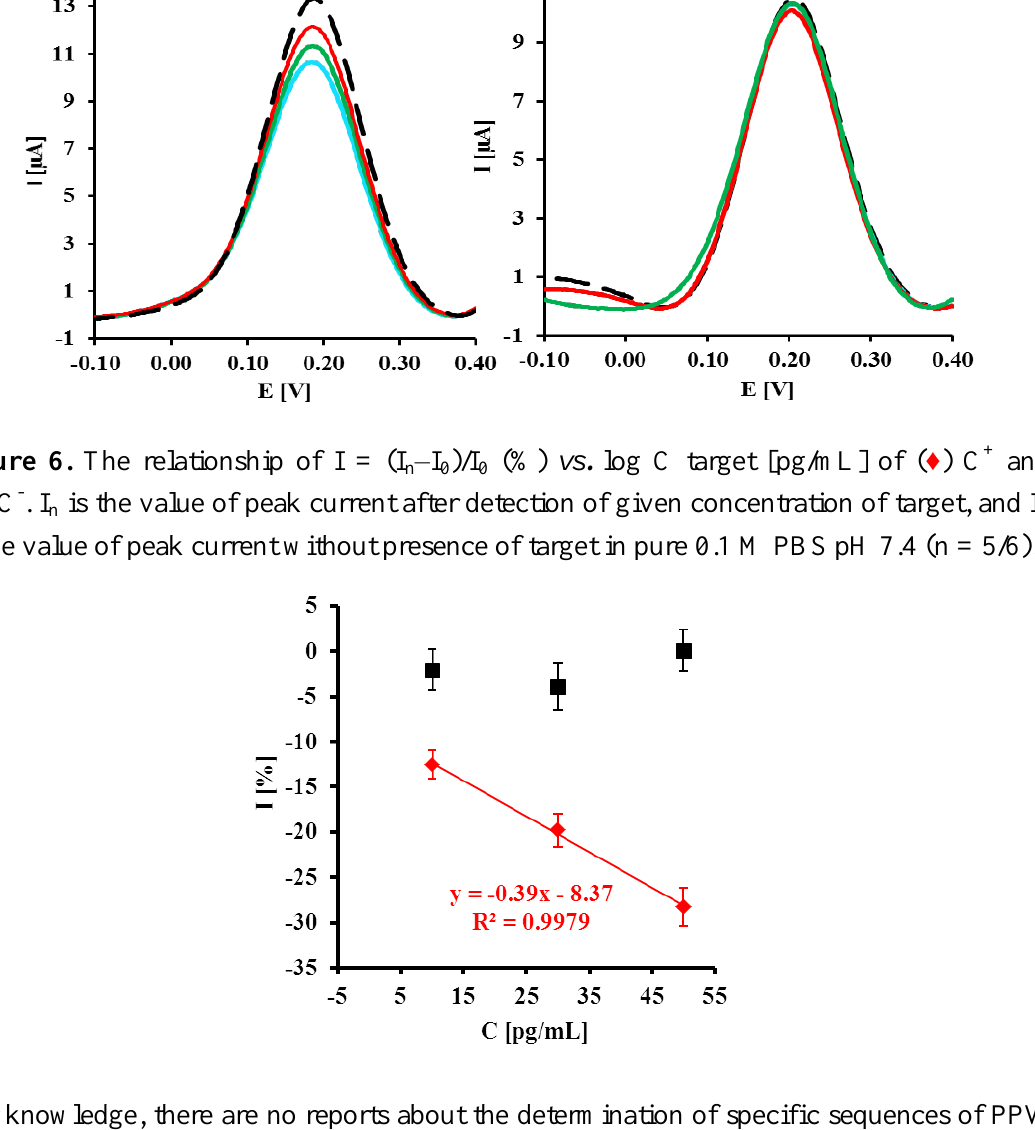
Figure 5. Typical OSWV curves obtained for electrodes modified with GCE-CO-NH-ssDNA-EA upon hybridization with DNA samples from plant extracts. Dashed curve—before hybridization and the following curves upon hybridization with target ( A ) C + PPV and ( B ) C − PPV at the concentrations: 10, 30 and 50 pg/mL. Solution composition: 1 mM [Fe(CN) ] 3−/4− in 0.1 M PBS (pH = 7.4). The measurement conditions: 6 three electrode configurations: GCE-CO-NH-ssDNA modified electrode, Ag/AgCl reference electrode and Pt counter electrode, frequency 25 Hz.